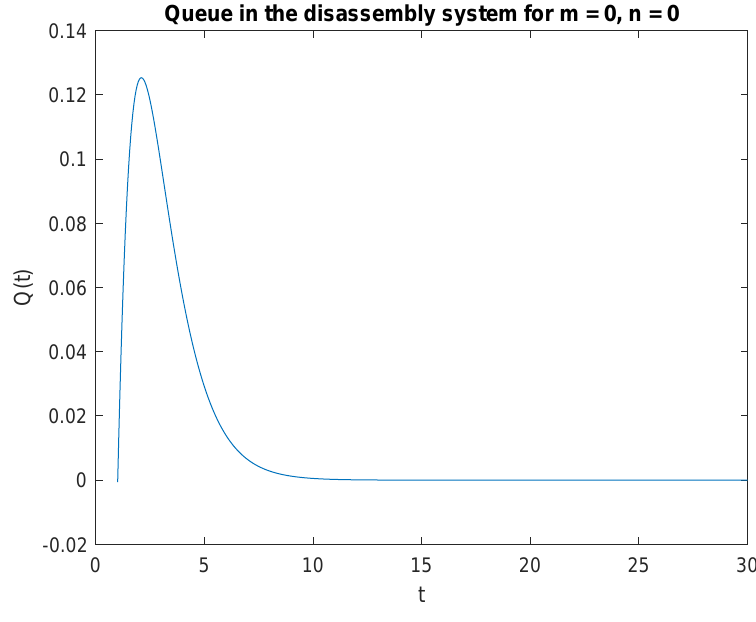
Figure 1. Impact of buffer state on probability P { X ( t ) = m = 0 | X ( 0 ) = n = 0 }